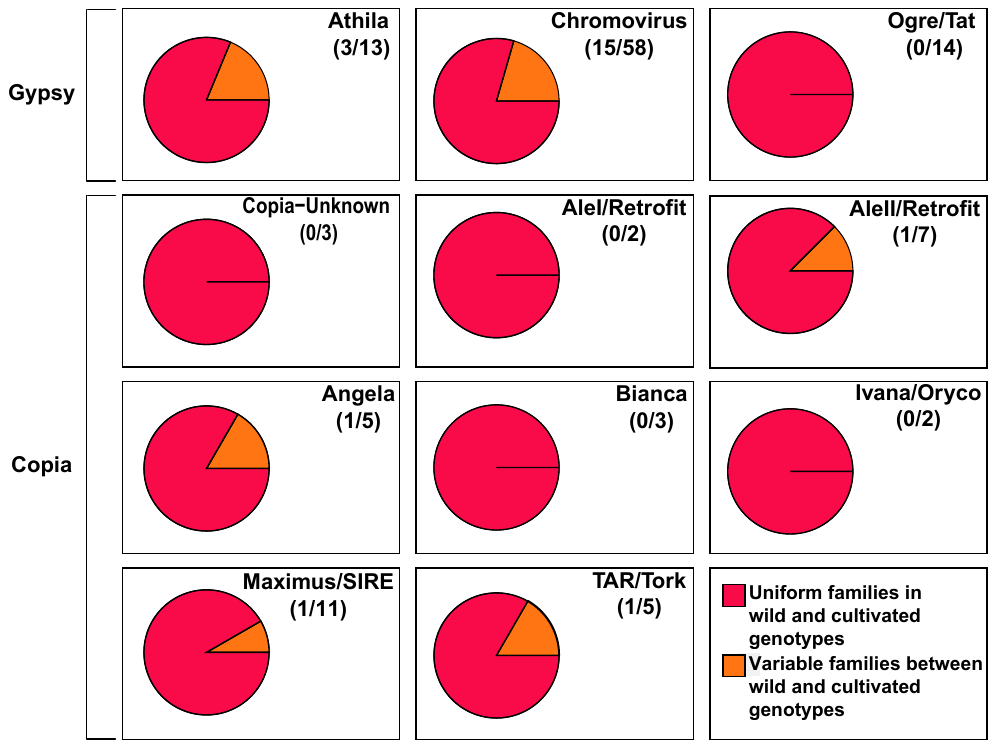
Figure 3. Percentage of long terminal repeats-retrotransposons (LTR-RE) families showing significant differences in abundance between wild and cultivated genotypes, according to the lineage to which such families belong. For each lineage, the total number of families in the sunflower genome is reported in